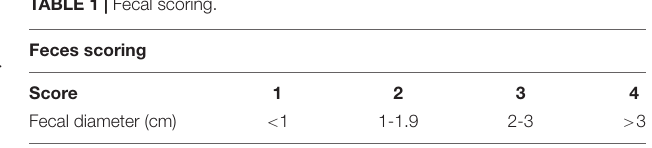
TABLE 1 | Fecal scoring.